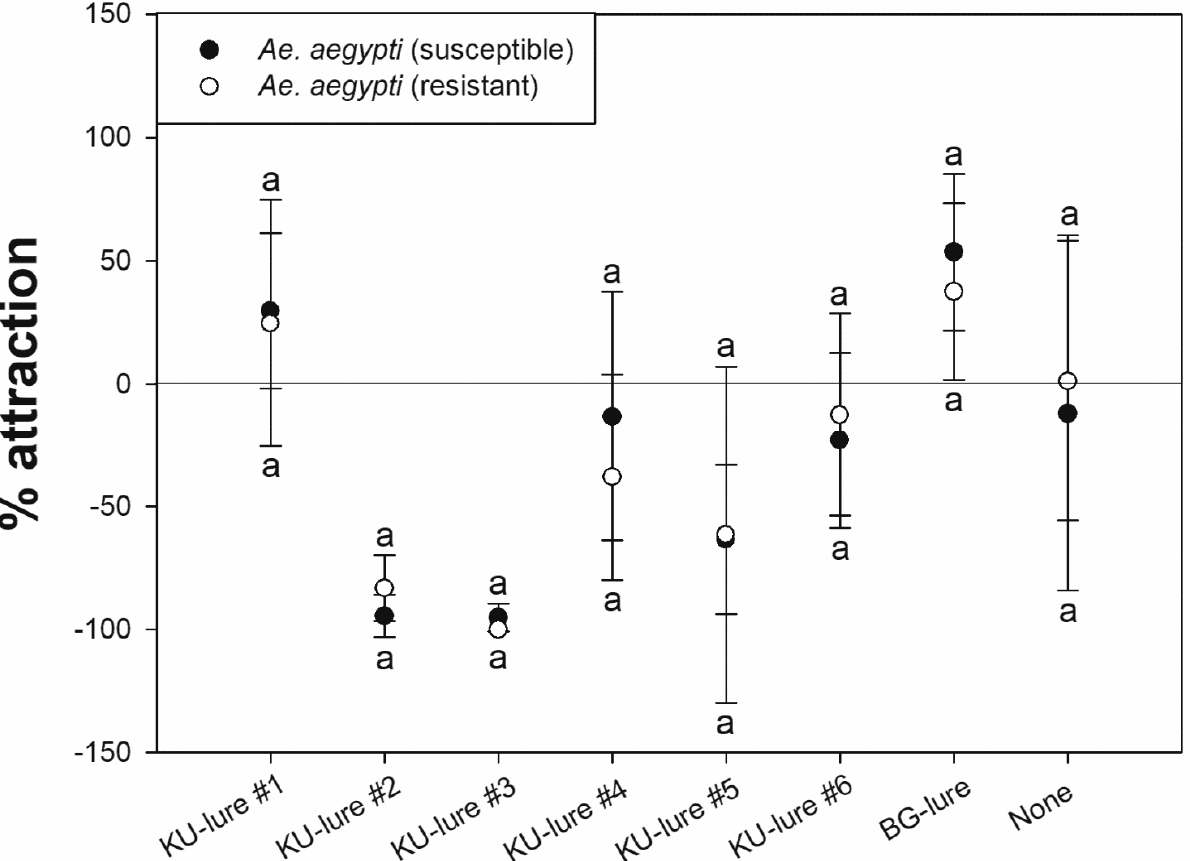
Figure 2. Percent attraction to each KU-lure (0.01 g) and BG-lure positive control (0.05 g) as measured by HITSS. Results are compared between pyrethroid-susceptible and -resistant strains of Aedes aegypti . A positive value indicates attraction to the treated chamber, while a negative value indicates repulsion from the treated chamber (more mosquitoes in the untreated chamber). For all lures, no significant difference in percent attraction was observed between mosquito strains (Mann–Whitney U test, p < 0.05).